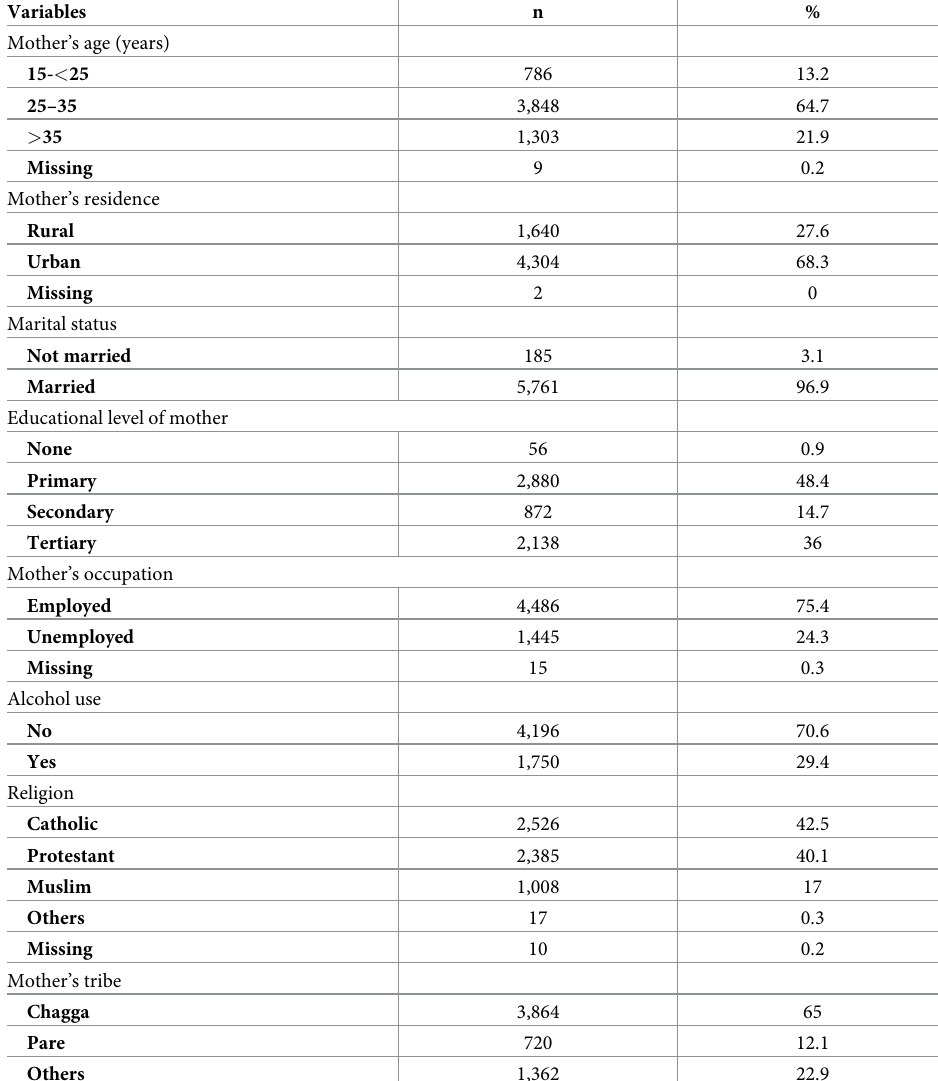
Table 1. Socio-demographic characteristics of women with consecutive deliveries (N =